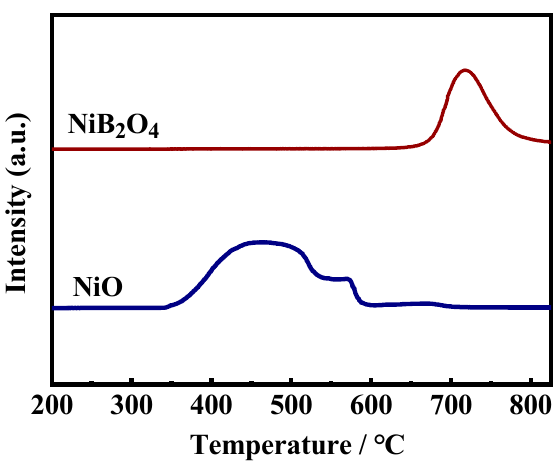
8 of 10 Figure 6. XRD patterns of model reactions products. The H 2 -TPR profiles of NiO and NiB 2 O 4 are displayed in Figure 7. As is exhibited, the